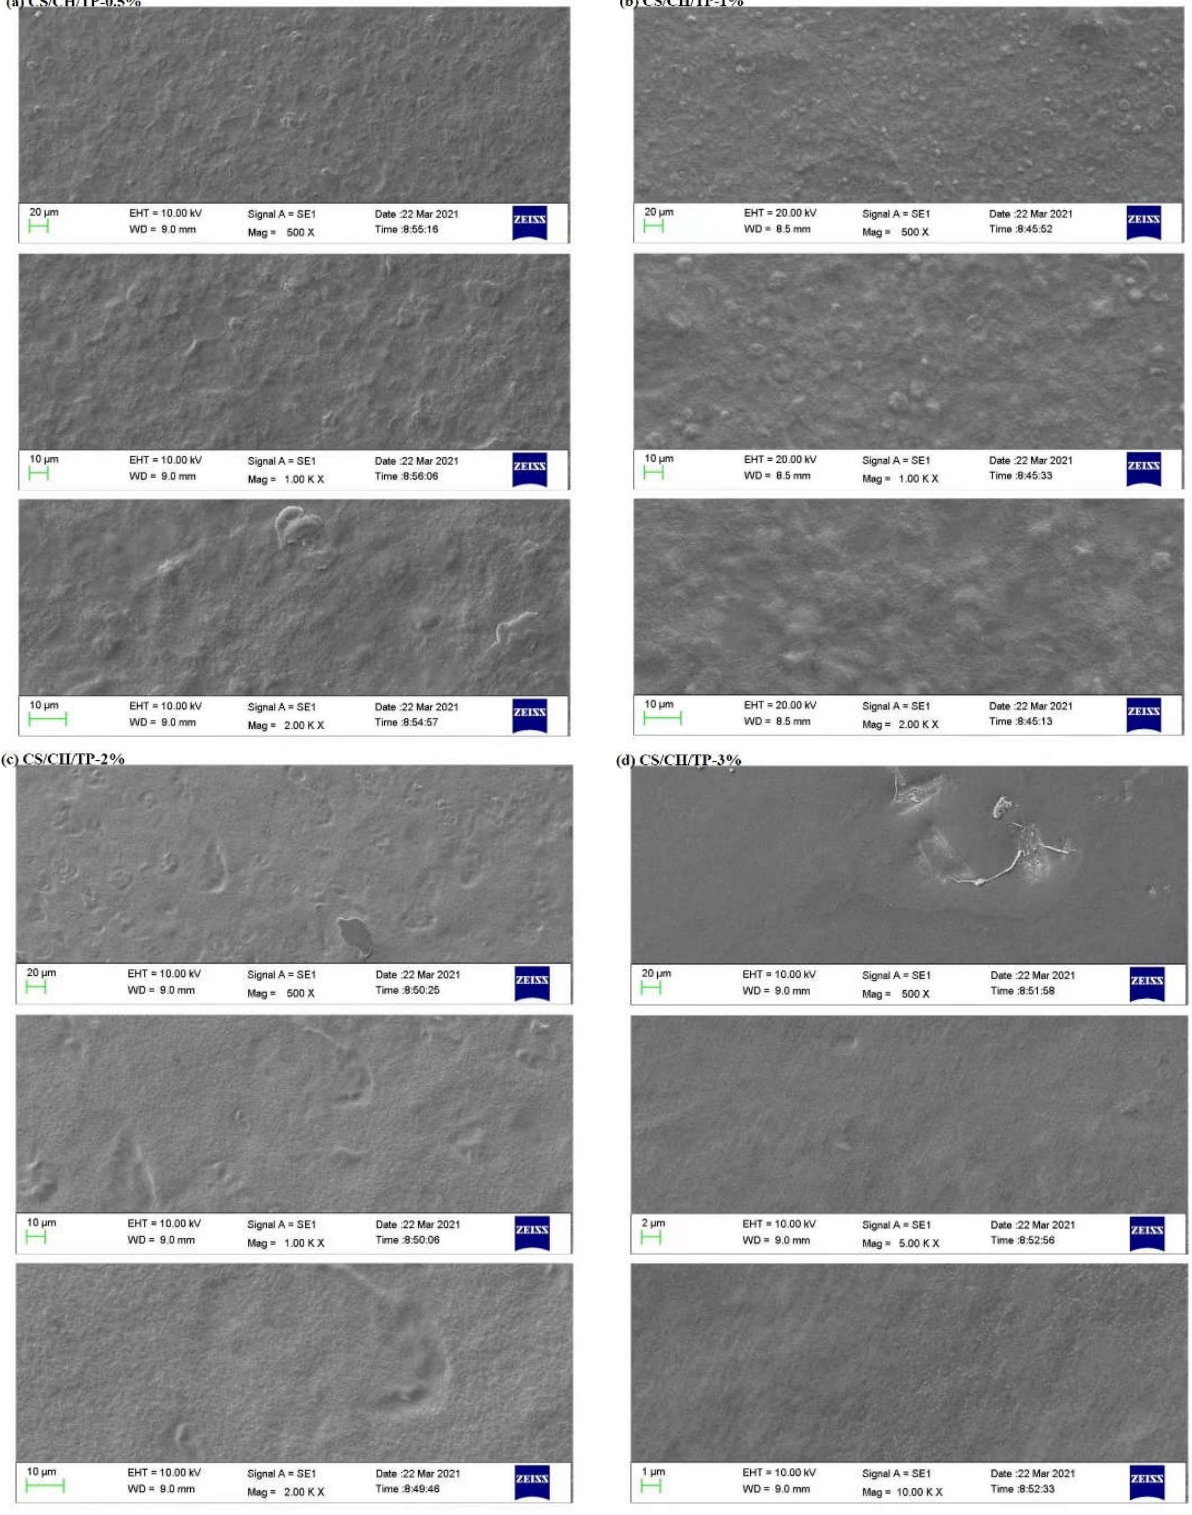
Figure 4. SEM micrographs of the surfaces of the blend films: ( a ) CS/CH/TP-0.5%, ( b ) CS/CH/TP-1%, ( c ) CS/CH/TP-2%, ( d ) CS/CH/TP-3%.